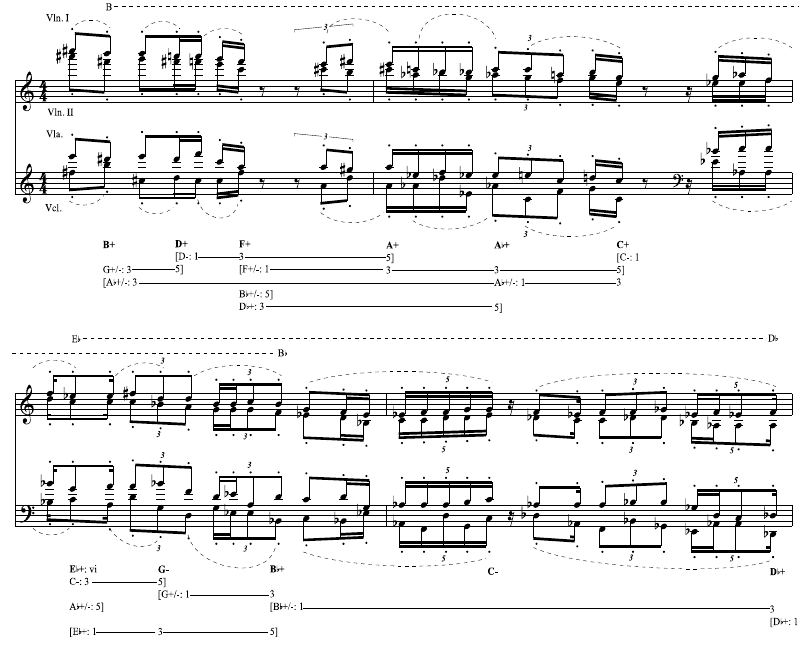
Figure 3. Macklay (2014) Many Many Cadences , measures